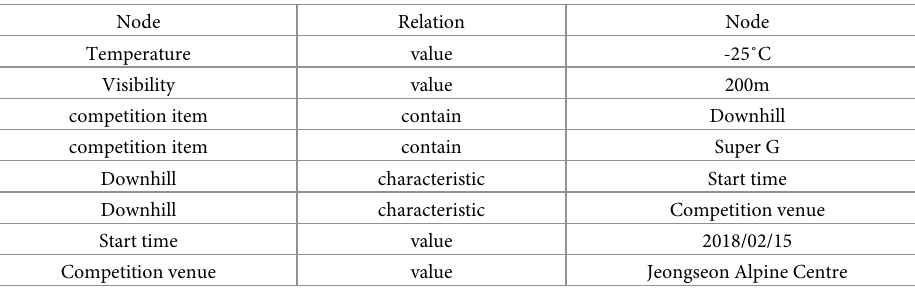
Table 4. Examples of simple